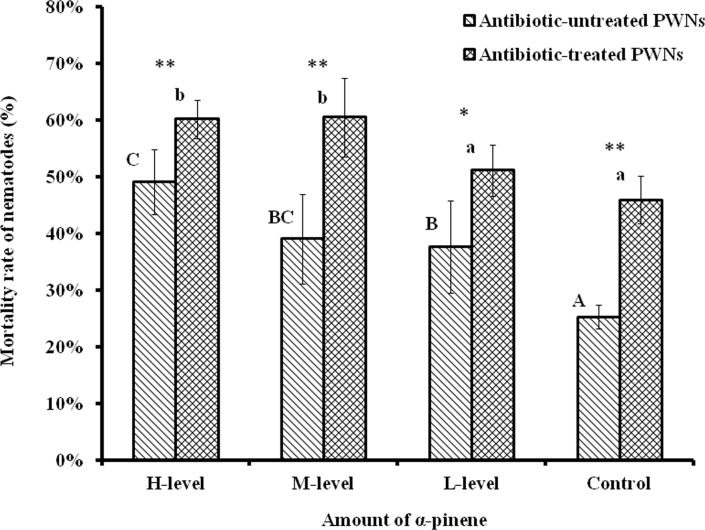
Mortality rate of nematodes.Different letters indicate significant (p < 0.05) differences in nematode mortality in corresponding nematode groups, as determined by Tukey's HSD test. Dots represent differences between two nematode groups (*p < 0.05, ** p < 0.01).